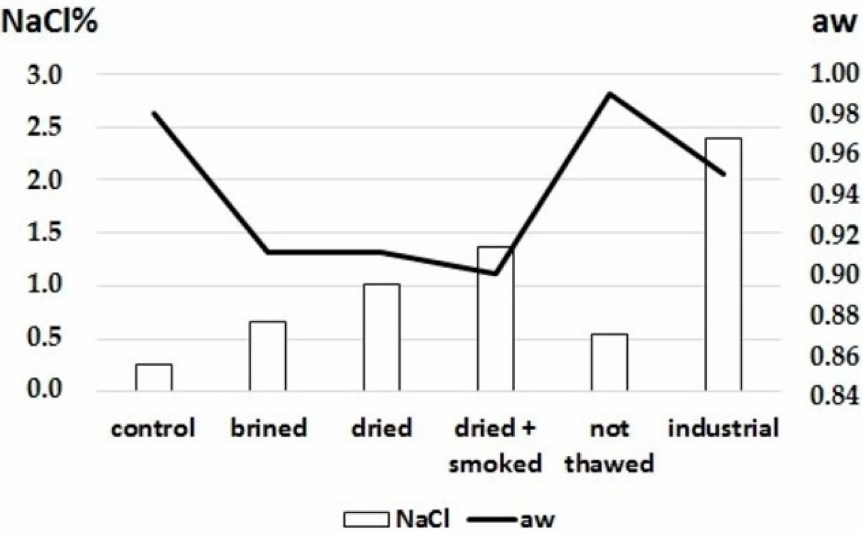
Figure 1. NaCl% content and aw values after different treatments were applied to swordfish fillets. aw: water